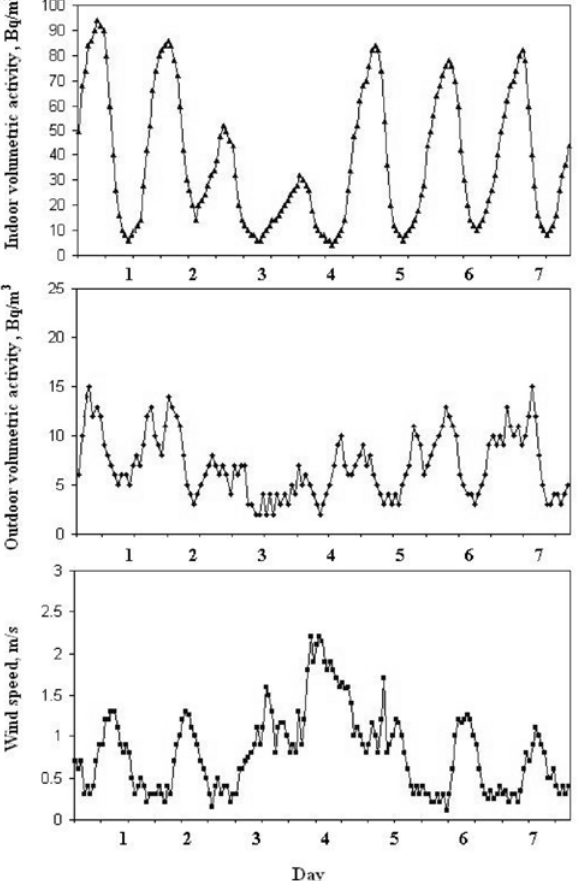
Fig 10. Shifts of 222 Rn progeny volumetric activity due to wind